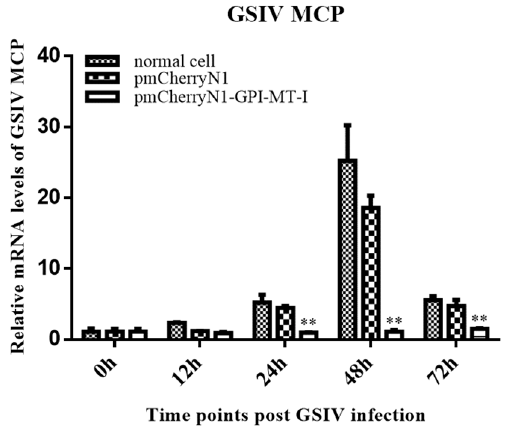
Figure 7. Effect of overexpression of AdGPI-MT-I on mRNA expression of major capsid protein (MCP) of GSIV detected by quantitative real-time PCR (qRT-PCR). The normal GSM cells and cells transfected with the empty vector plasmid were set as the control group, and the experimental group was transfected with pmCherryN1-AdGPI-MT-I plasmid for 48 h. At 0, 12, 24, 48, and 72 h after GSIV infection (MOI = 0.1), cell samples were collected for RNA extraction, and the transcription levels of the MCP gene were detected by qRT-PCR. All the experiments were repeated three times. Data are the means of three independent assays and presented as means ± SD; ** p <